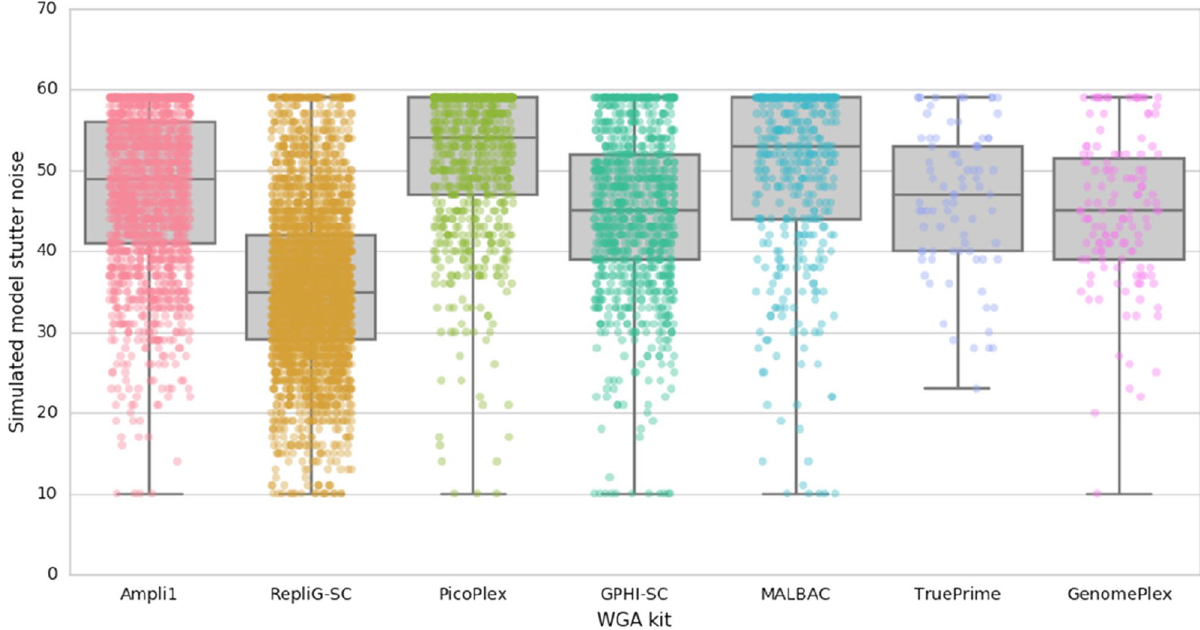
Figure 3. Error rate analysis of different scWGA kits. Simulated model stutter noise was fitted for AC type STR loci targets as part of the STR genotyping process 14 . RepliG-SC demonstrated the least stutter accumulation as expected from an MDA based method. PCR based protocols accumulate more relative stutter, equivalent to up to 20 additional PCR cycles. The targets were chosen from the X chromosome and covered with at least 30X reads, therefore a clear mono-allelic signal is expected. Indeed, high correlations between the model and measured stutter patterns are evident in Supplementary Fig. 3, regardless of the amount of simulated model stutter